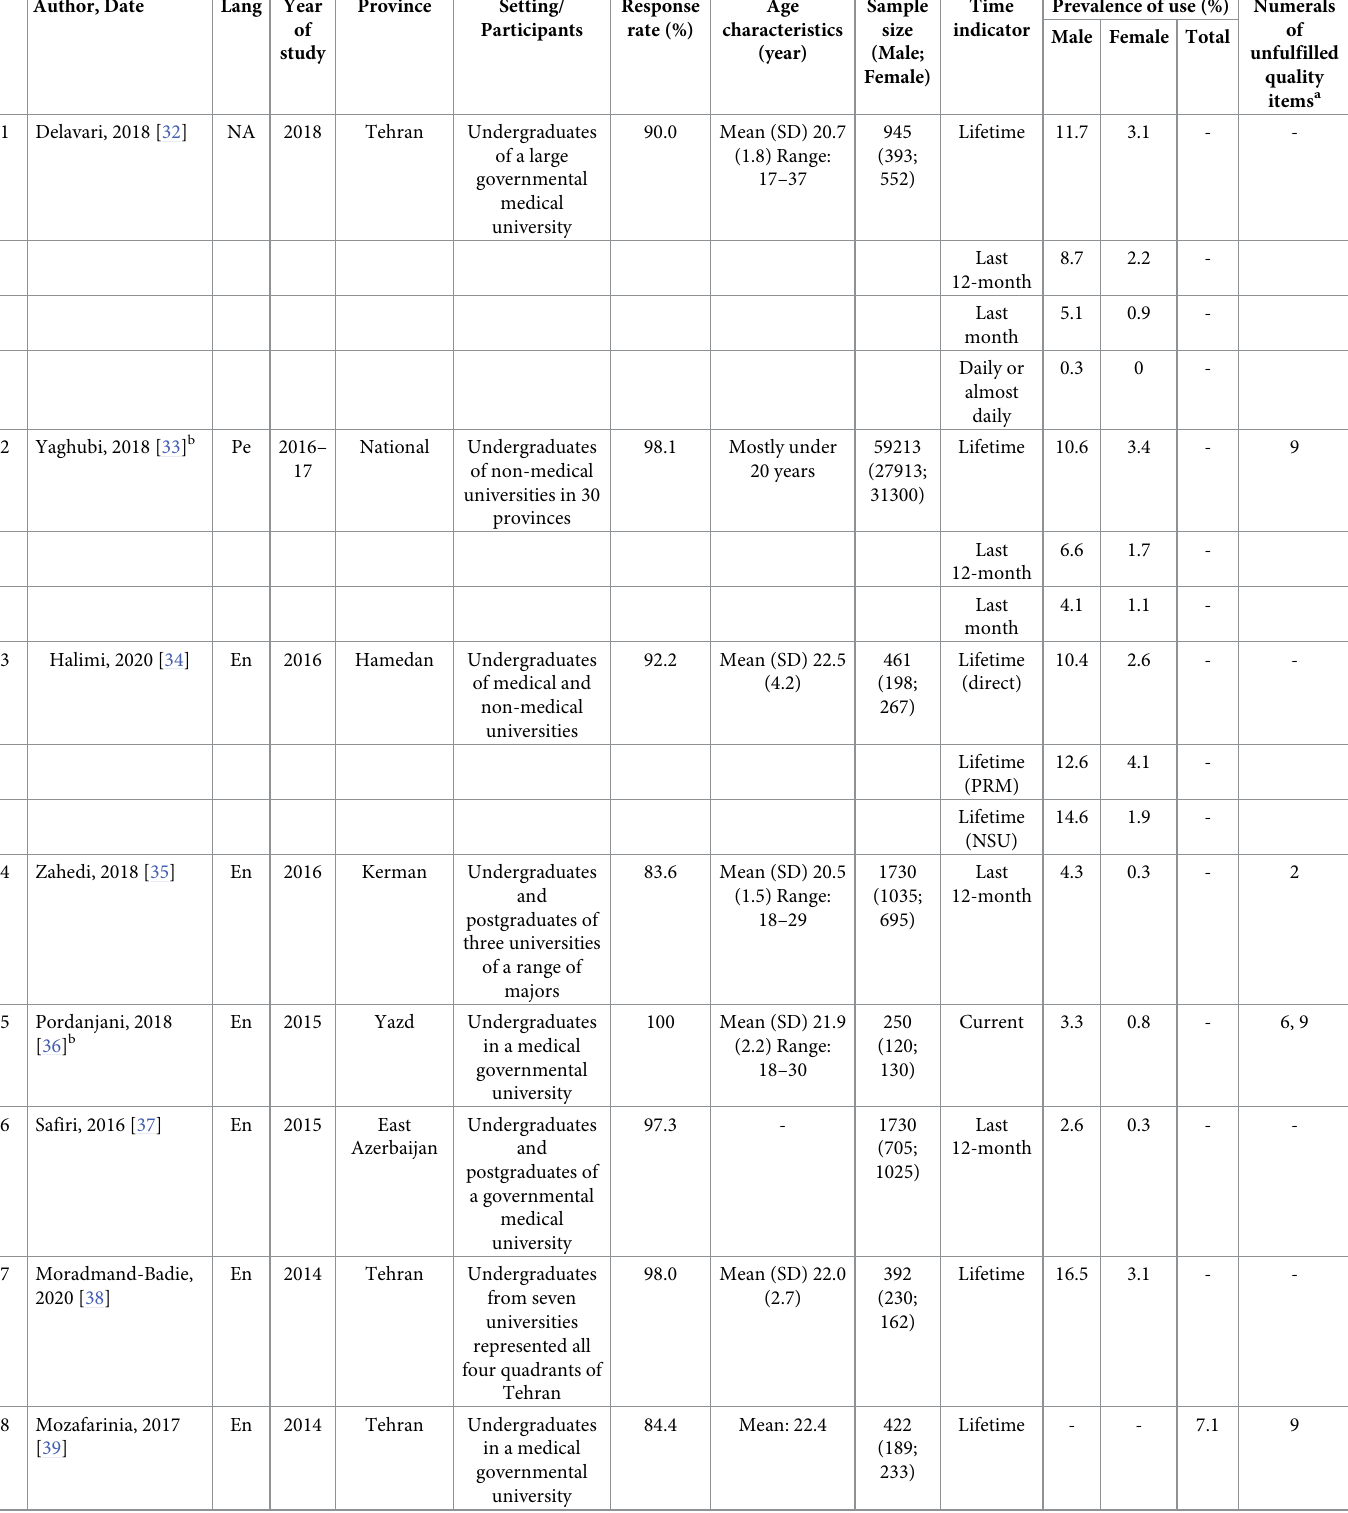
Table 2. Characteristics and results of studies on the prevalence of cannabis use among the university